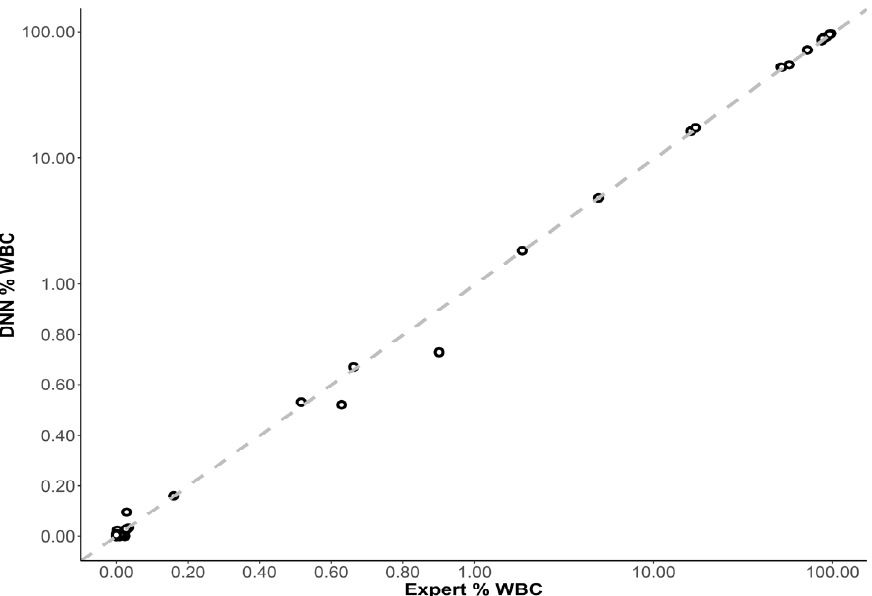
Figure 4. Scatterplot showing expert and DNN inference of abnormal CLL events as a % of total white blood cells (WBCs) for each unknown case (n = 60, including the serial dilution samples). The dashed line represents the Passing–Bablok regression line: slope = 0.997 (95% CI: 0.988–0.999) and intercept = 0.001 (95% CI: 0.000–0.001).